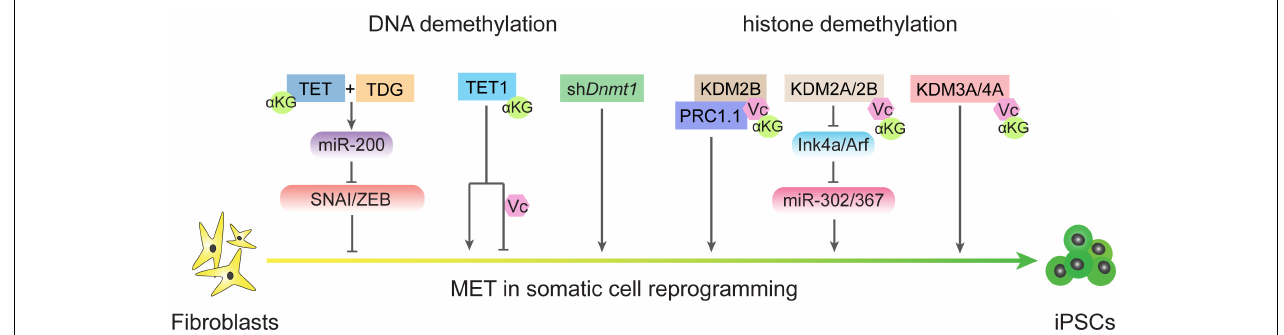
FIGURE 4 | DNA demethylation and histone demethylation regulate MET process during reprogramming. TET and TDG are essential for early MET through demethylating miR-200 loci and TET1 plays different roles in reprogramming in condition of the present or absent of vitamin C. Passive DNA demethylation through knockdown the expression of Dnmt1 also promote MET. Histone demethylases also regulate MET process in different